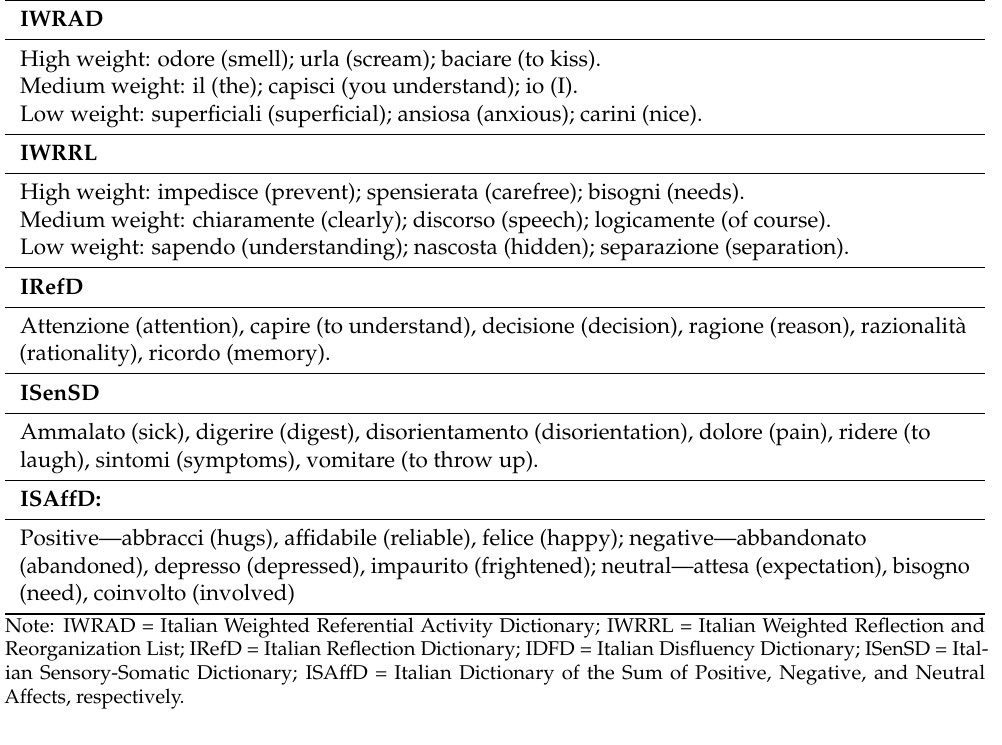
Table 1. Examples of words belonging to Italian linguistic measures of the referential